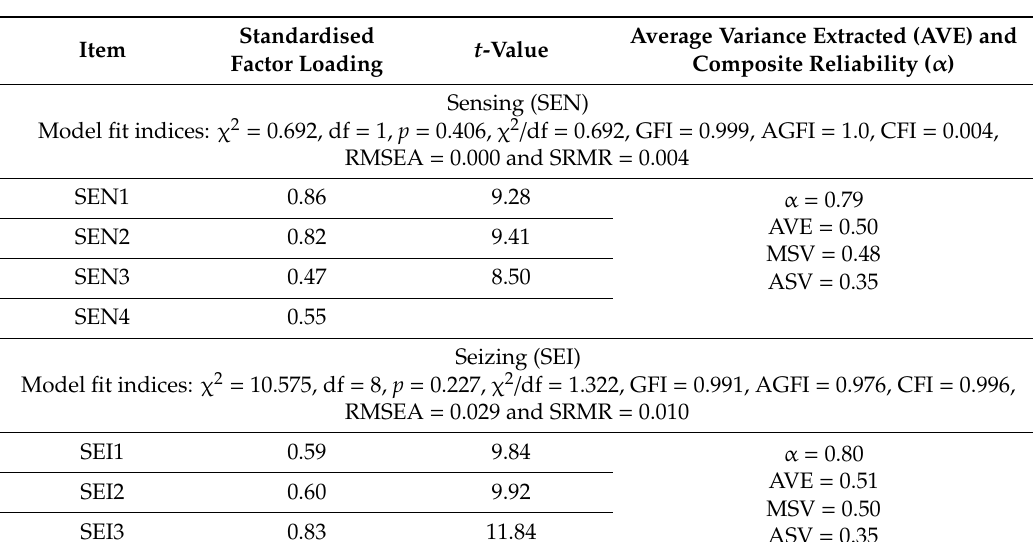
Table 2. Confirmatory factor